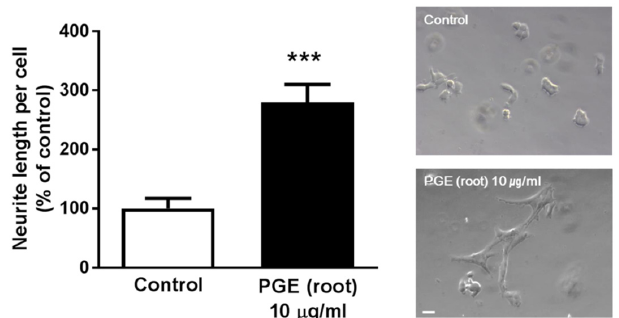
Figure 6. In vitro assay to confirm PGE (root)-induced neuritogenesis in PC12 cells. PC12 cells were treated with 10 µg/mL PGE (root) for 24 h and the cells show a significant increase in neurite length compared to the controls. Values are the mean + SEM. *** p < 0.05 compared to the vehicle-treated control group. Scale bar = 20 µm. PGE, Platycodon grandiflorus extract.